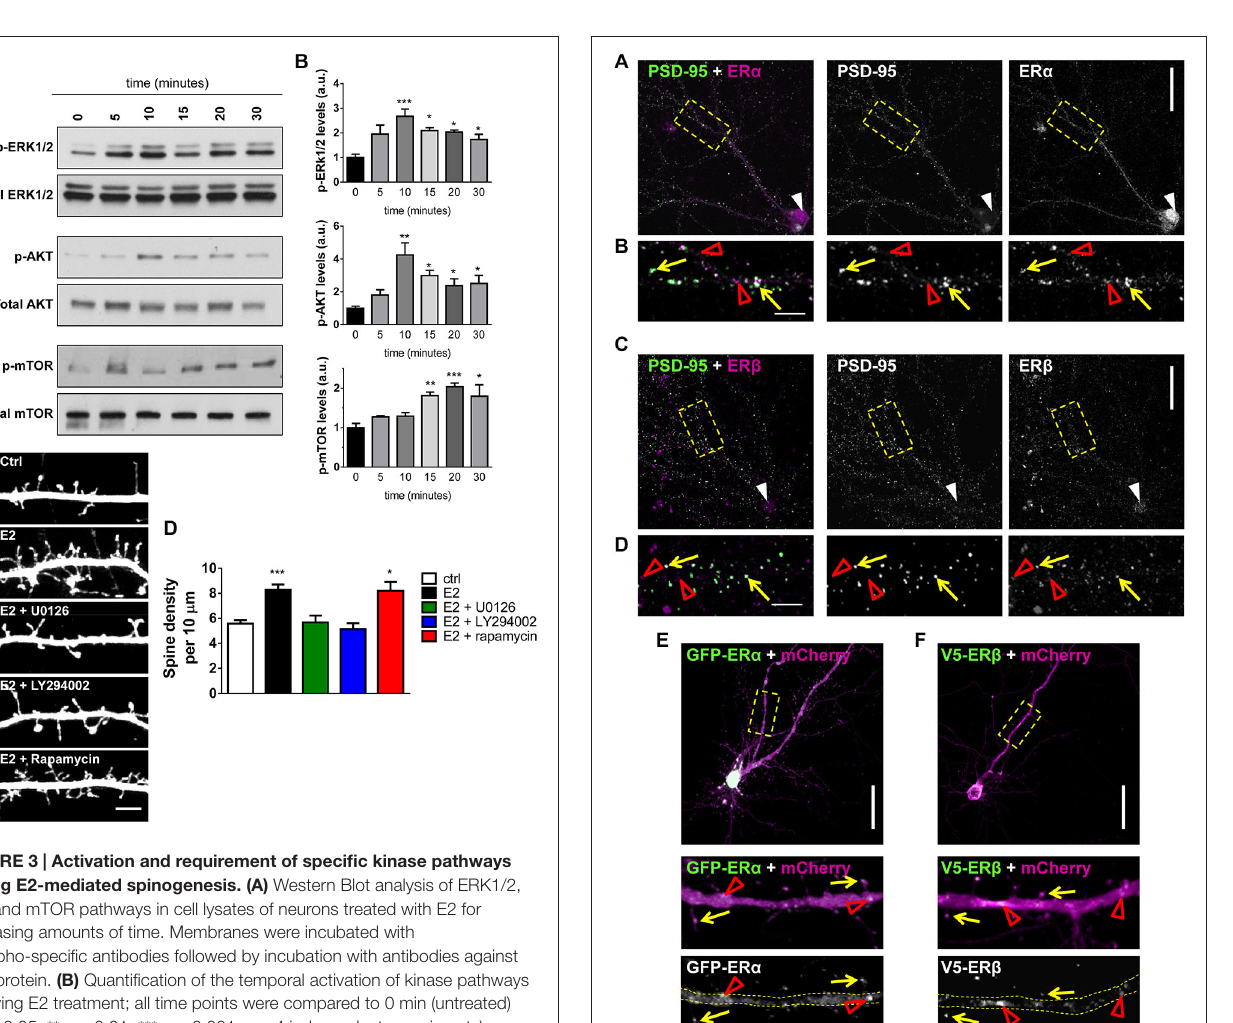
nucleus (white arrow heads) and in punctate structures along the dendrite ( Figure 4C ). ER β puncta were also observed along